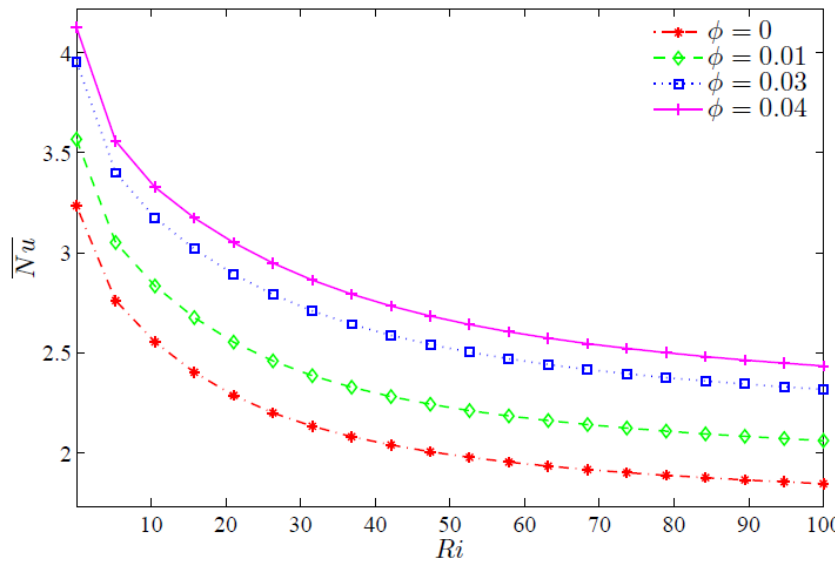
Figure 9. (cid:1840)(cid:1873) (cid:3364) (cid:3364)(cid:3364)(cid:3364) vs. Ri for various (cid:2038) at (cid:1840) = 3 . Figure 9. Nu vs. Ri for various φ at N = 3. Figure 9. (cid:1840)(cid:1873)(cid:3364)(cid:3364)(cid:3364)(cid:3364) vs. Ri for various (cid:2038) at (cid:1840) = 3 .